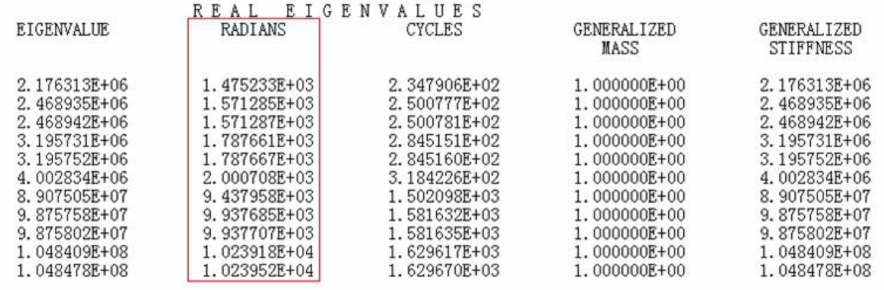
Figure 7. F06 data